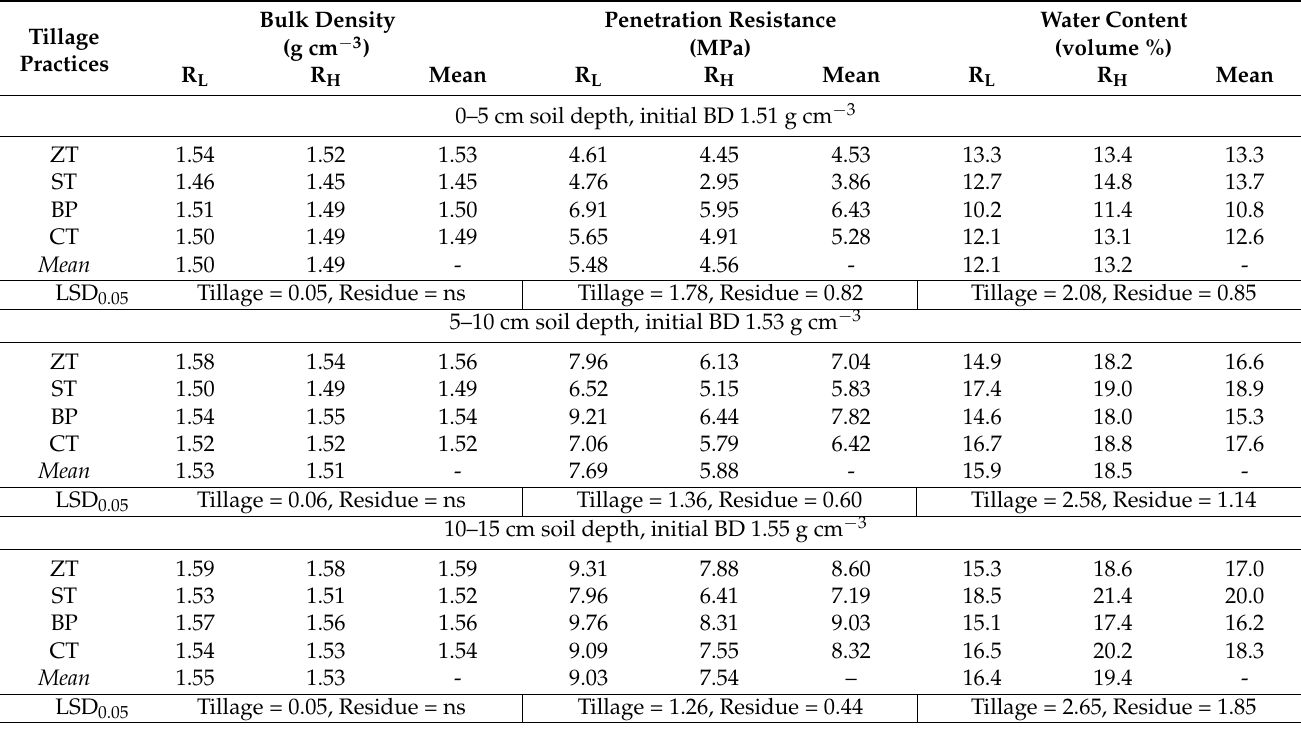
Table 3. Effect of tillage practices and residue retention levels on soil bulk density, penetration resistance and water content in soils after 8th crop